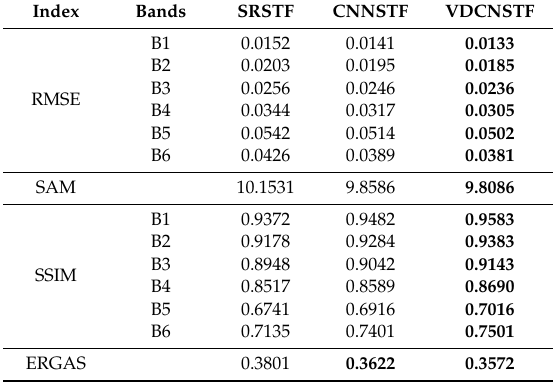
Table 3. Quantitative evaluations of the fusion results in Figure 9. Bold fonts indicate better